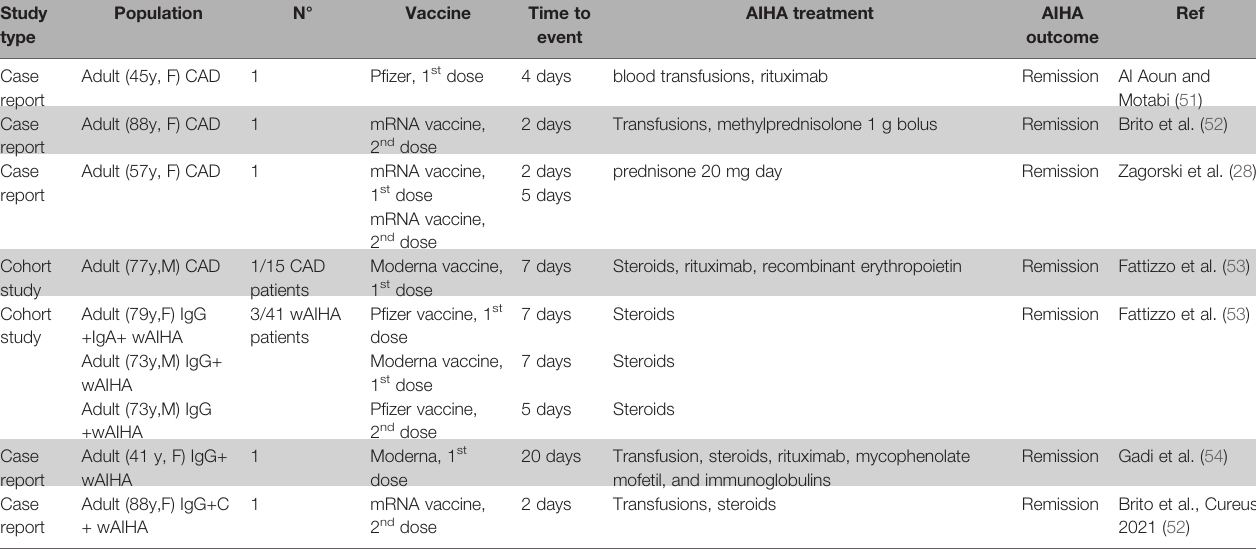
TABLE 4 | Hemolytic fl ares in patients with cold agglutinin disease (CAD) and warm autoimmune hemolytic anemia (wAIHA) after SARS-CoV-2 vaccine. Study